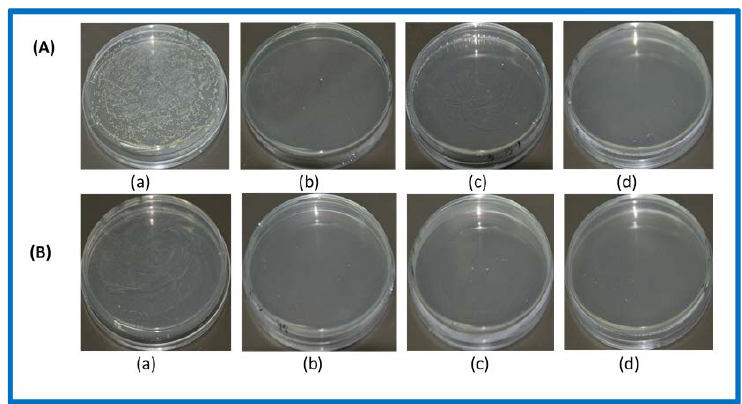
Figure 4. The antibacterial effect of PR-(SD-Ag) on ( A ) E. coli and ( B ) S. aureus : ( a ) blank groups (PR 2 24 h ); ( b ) PR 2 24 h -(SD-Ag)2:1; ( c ) PR 2 24 h -(SD-Ag)1.5:1; ( d ) PR 2 24 h -(SD-Ag)1:1.